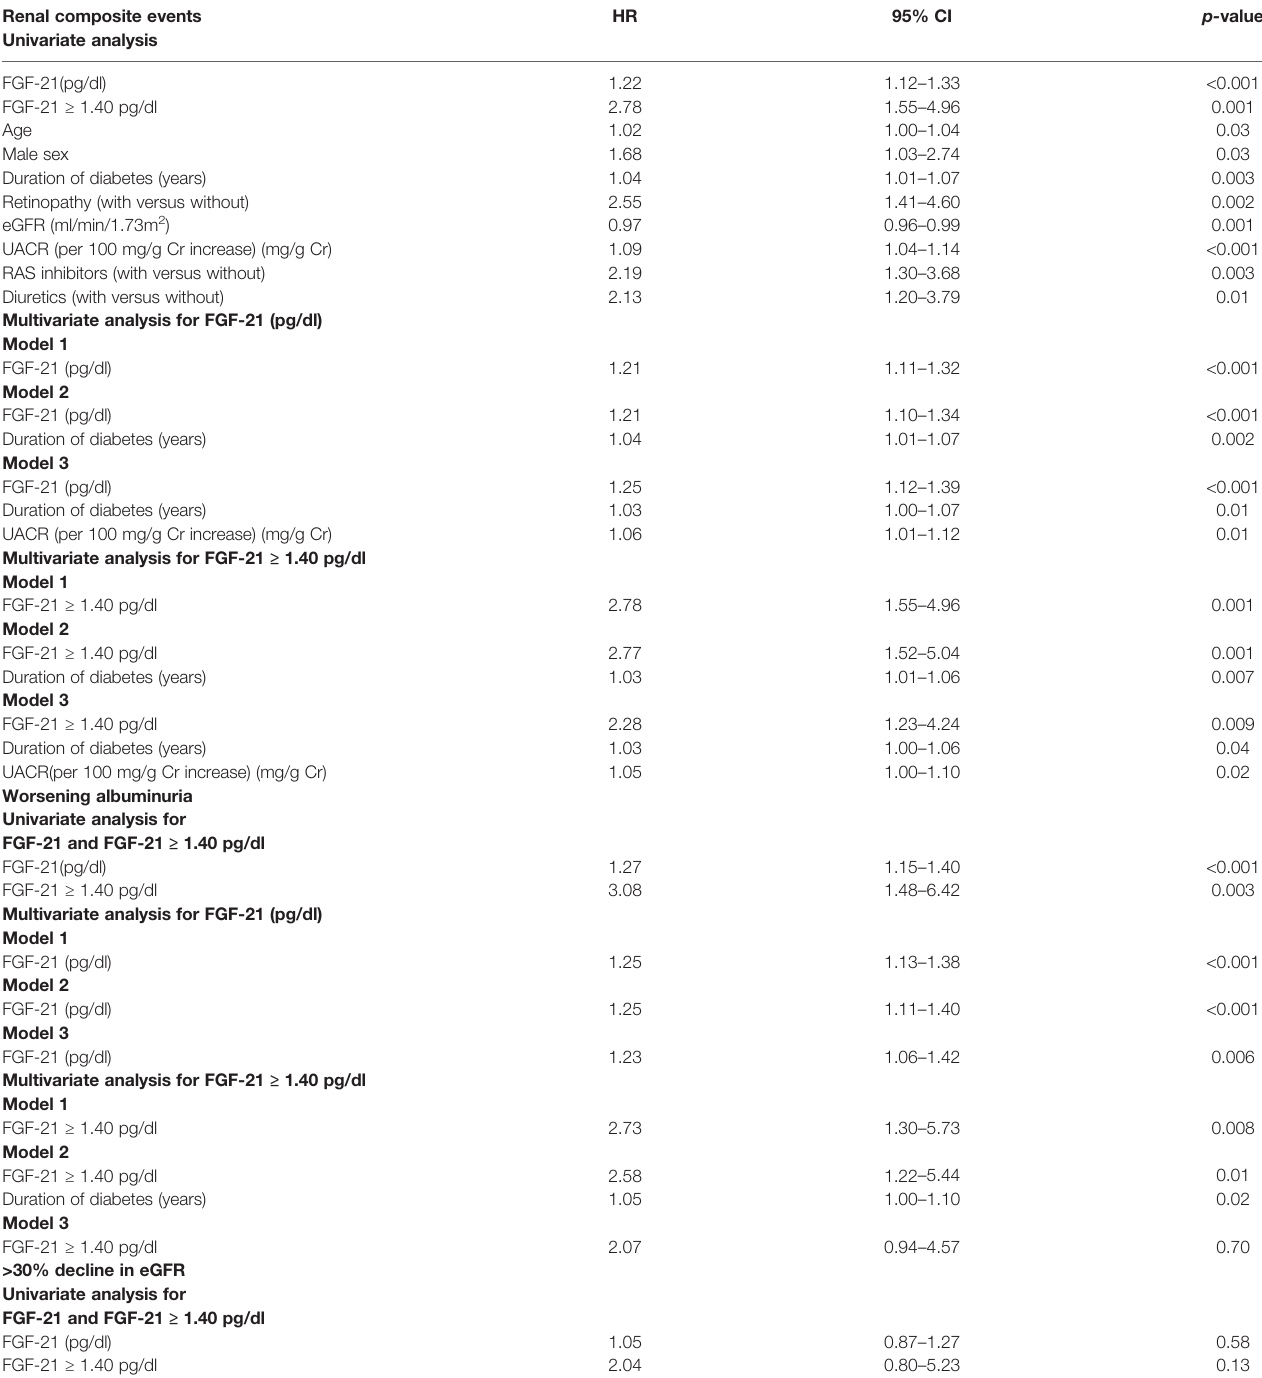
TABLE 2 | Result of univariate and multivariate Cox proportional hazard model for association of FGF-21 with renal composite